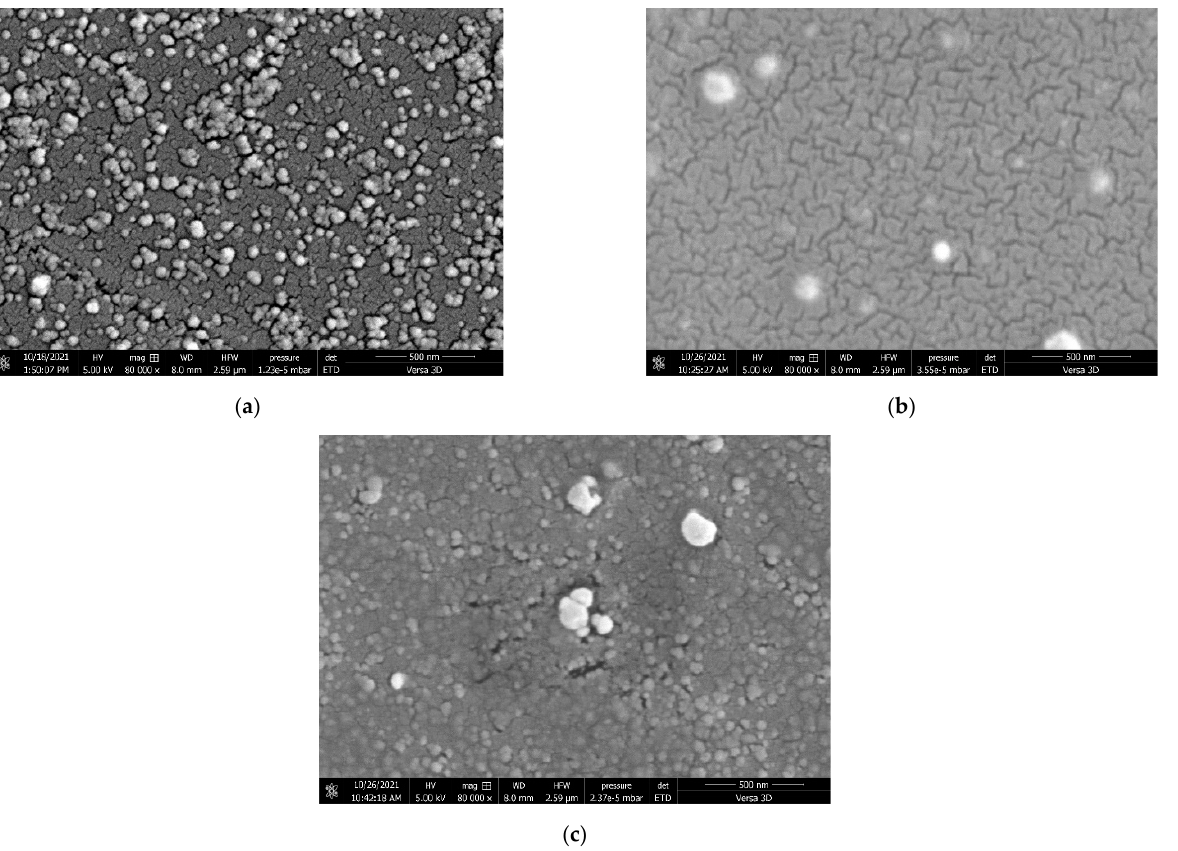
Figure 2. FE-SEM images showing the spherical morphology of CCG-NP ( a ) C2, ( b ) C10, and ( c ) C16 at 80,000× magnification.